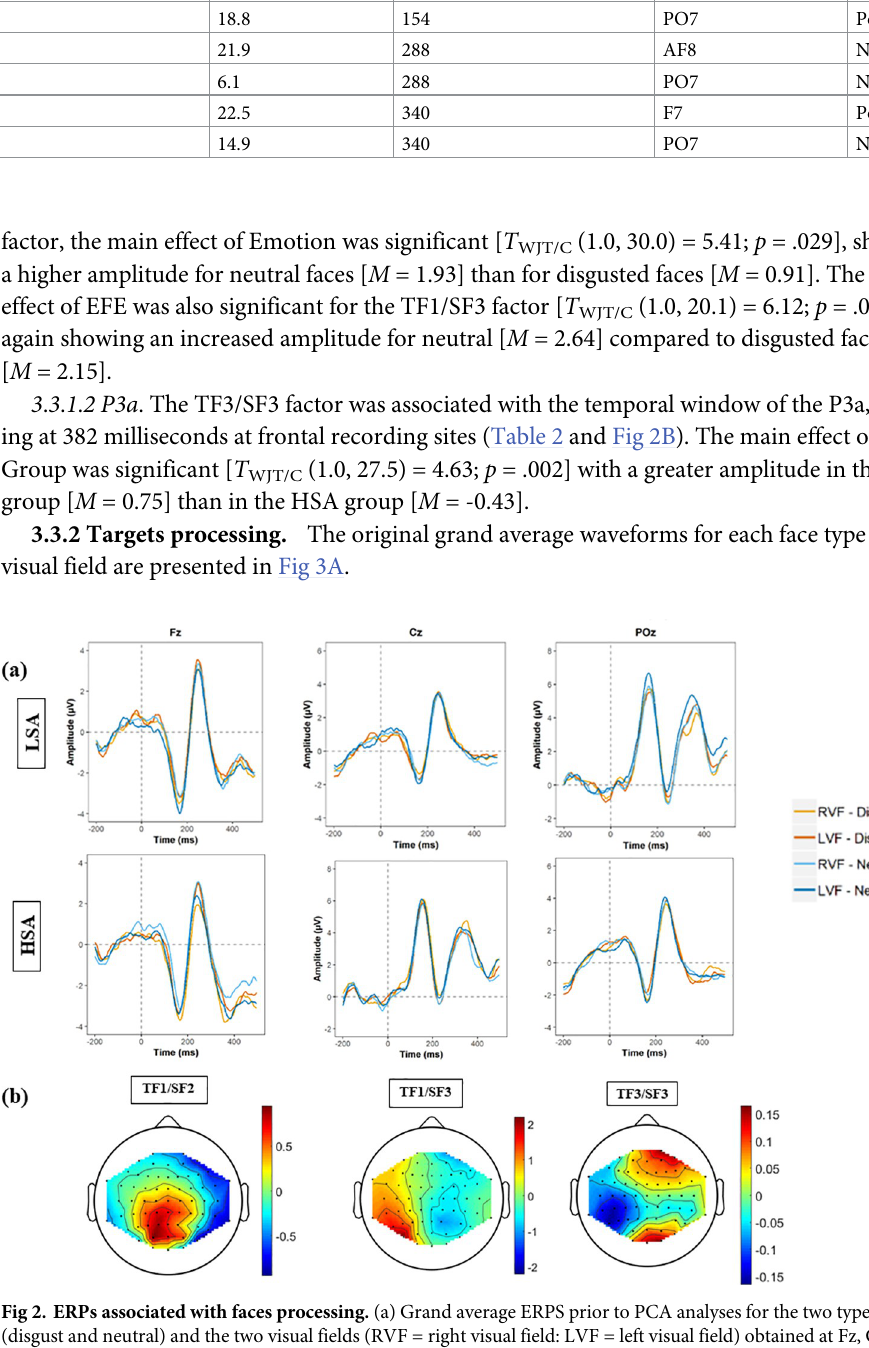
Table 2. PCA factor combinations selected for further analysis on faces and targets processing.